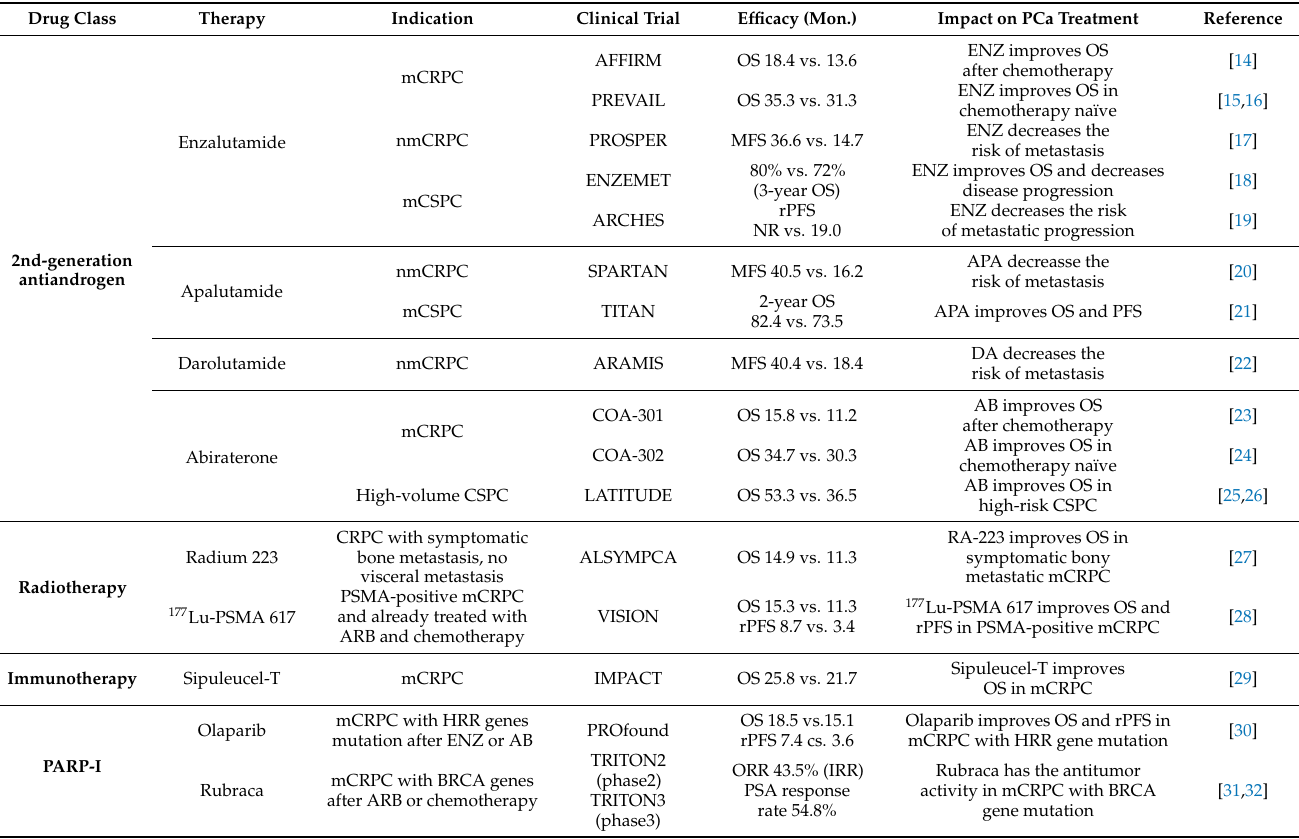
Table 1. FDA-approved therapies for prostate